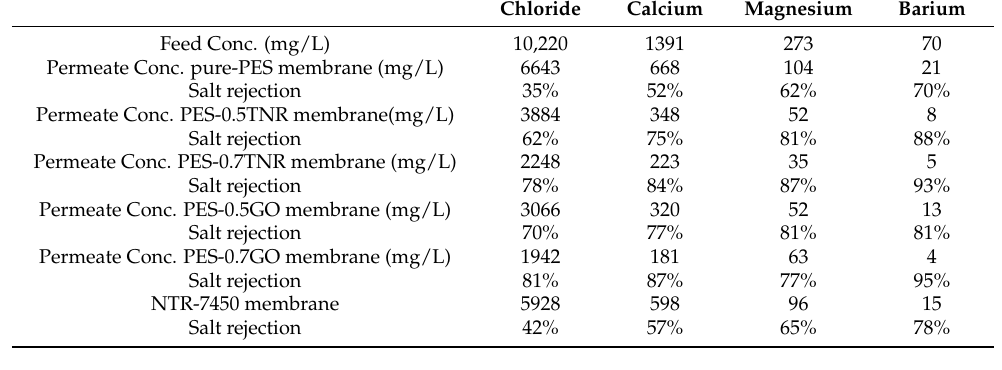
Table 4. Permeate concentration after filtration using synthesized membranes and related filtration ef- ficiencies.